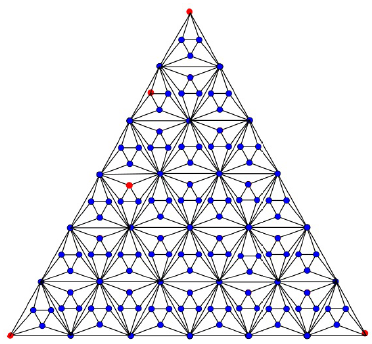
Figure 3. Triangular hex-derived network of type 3 ( THDN 3 ( 7 ) ).